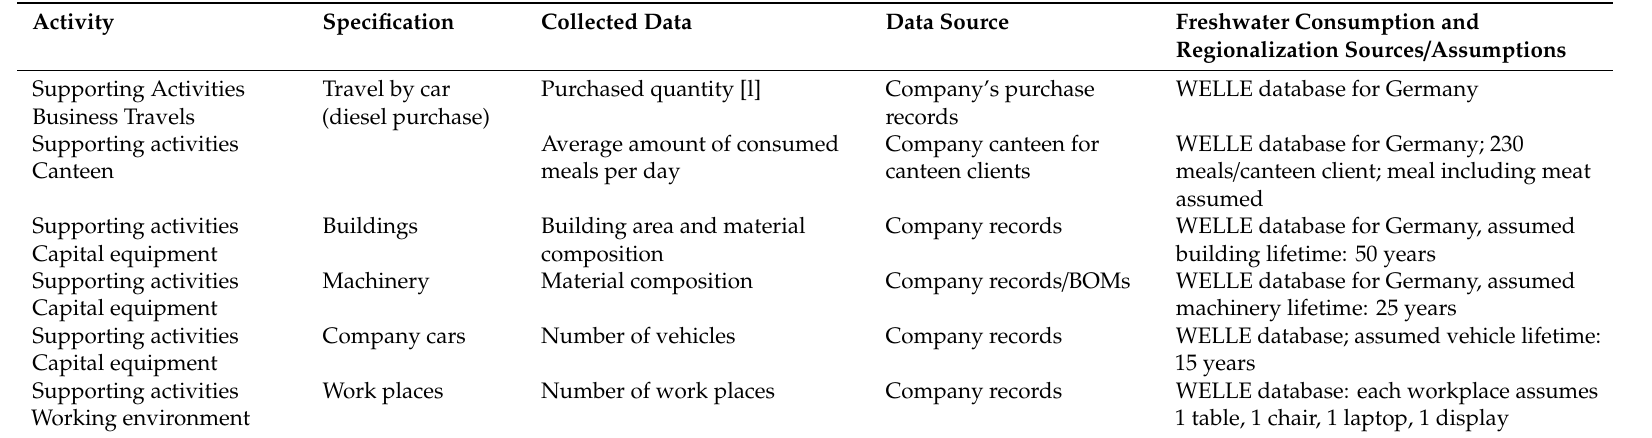
Table A2. Data sources and assumptions for supporting